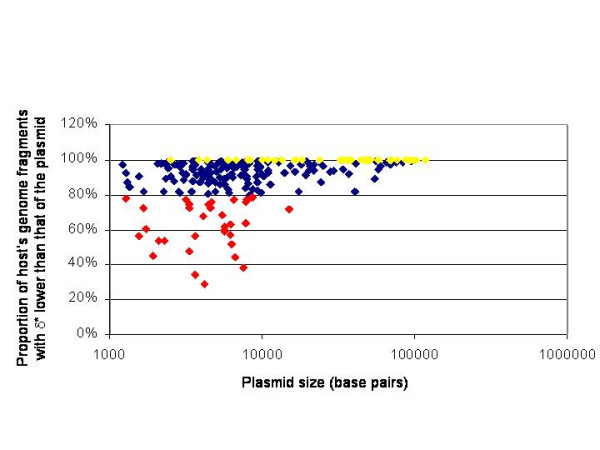
Compositional discordance between plasmids and their host's according to the plasmid size. The proportion of genomic fragments of the representative host chromosome with a δ* value lower than that of the plasmid is plotted as a function of plasmid size. Note the logarithmic scale on the X axis. Thirty-five plasmids have a δ* value lower than that of 80% (values range from 29% to 80%) of the identical sized fragments of their host's genome (red symbols), while 42 plasmids have a δ* value higher than all identical sized fragments of their host's genome (yellow symbols).